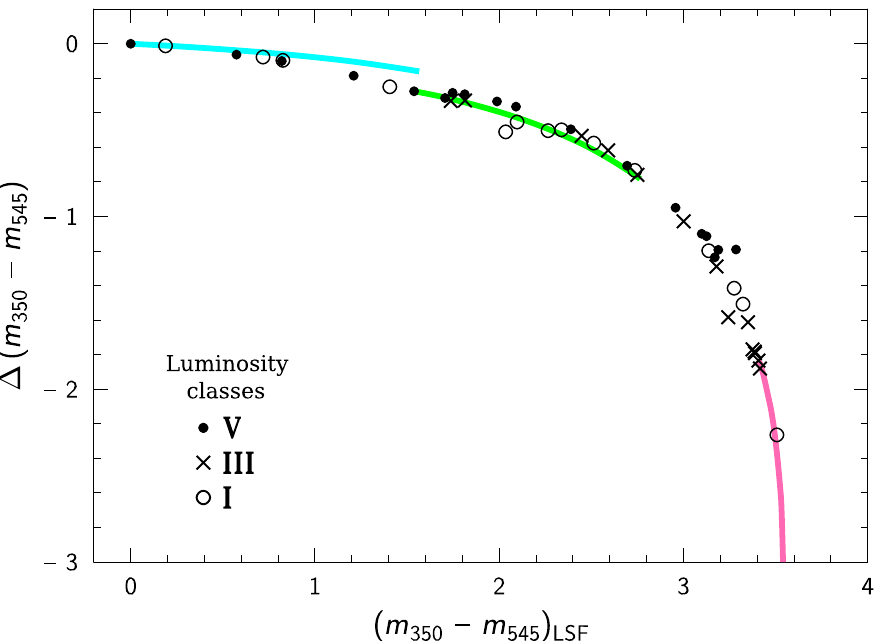
Fig. 8a. Decontamination corrections for the color index m 350 – m 545 simulated from the Gaia BP spectra plotted as a function of the contaminated ‘color index’. Red- dening lines for the stars O8 V, A0 V and K5 III up to A V = 3 mag are shown.